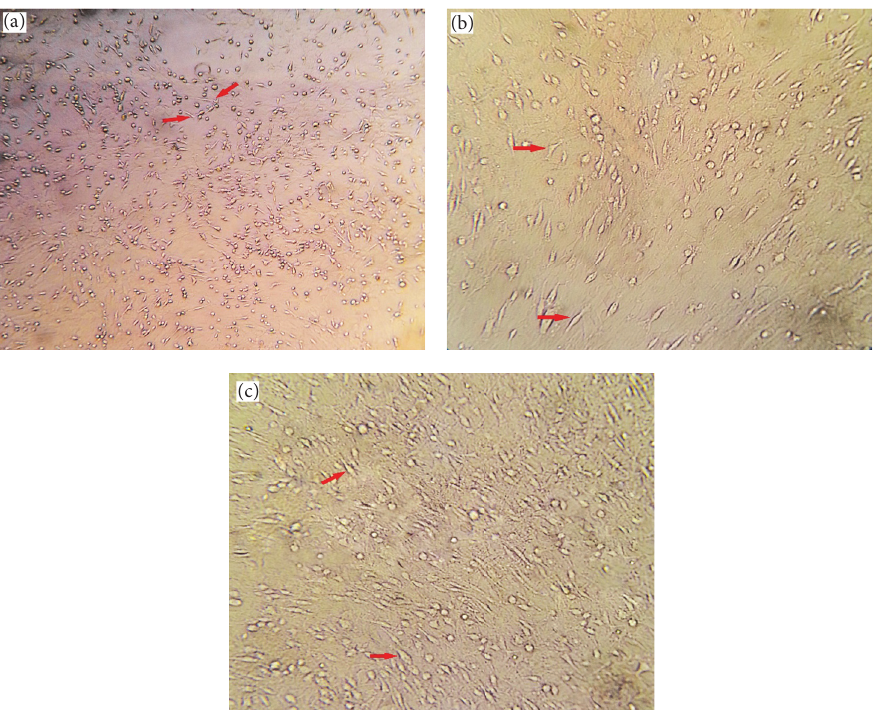
Figure 1: Various stages of cultured bone marrow stromal cells. Bone marrow stromal cell morphology in the early (a), middle (b), and late (c) subculture